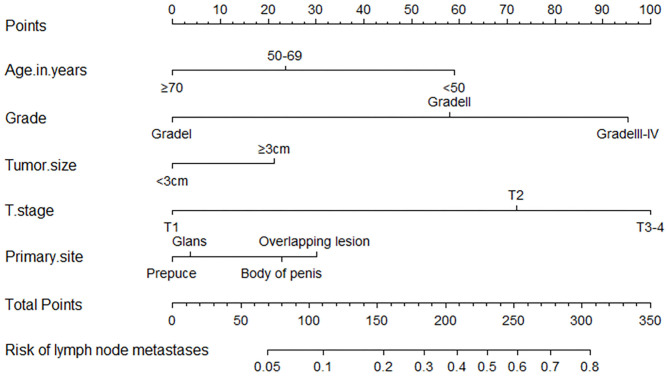
A nomogram for predicting the probability of lymph node metastases. To use the nomogram, the value for each predictor is determined by drawing a line upward to the point reference line, the points are summed, and a line is drawn downward from the total points line to find the predicted probability of lymph node metastases.